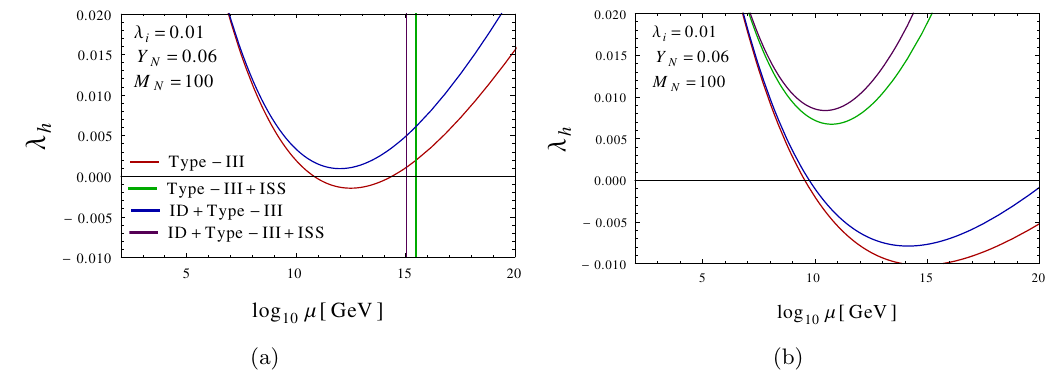
Figure 5 . Two loop running of the SM like Higgs quartic coupling as a function of energy. Here the red, green, blue and the purple curve correspond to the Type-III Seesaw, Type-III Seesaw+ISS, ID+Type-III Seesaw and ID+Type-III Seesaw+ISS scenarios. The left and right plot represent three generations and two generations of fermionic triplets,